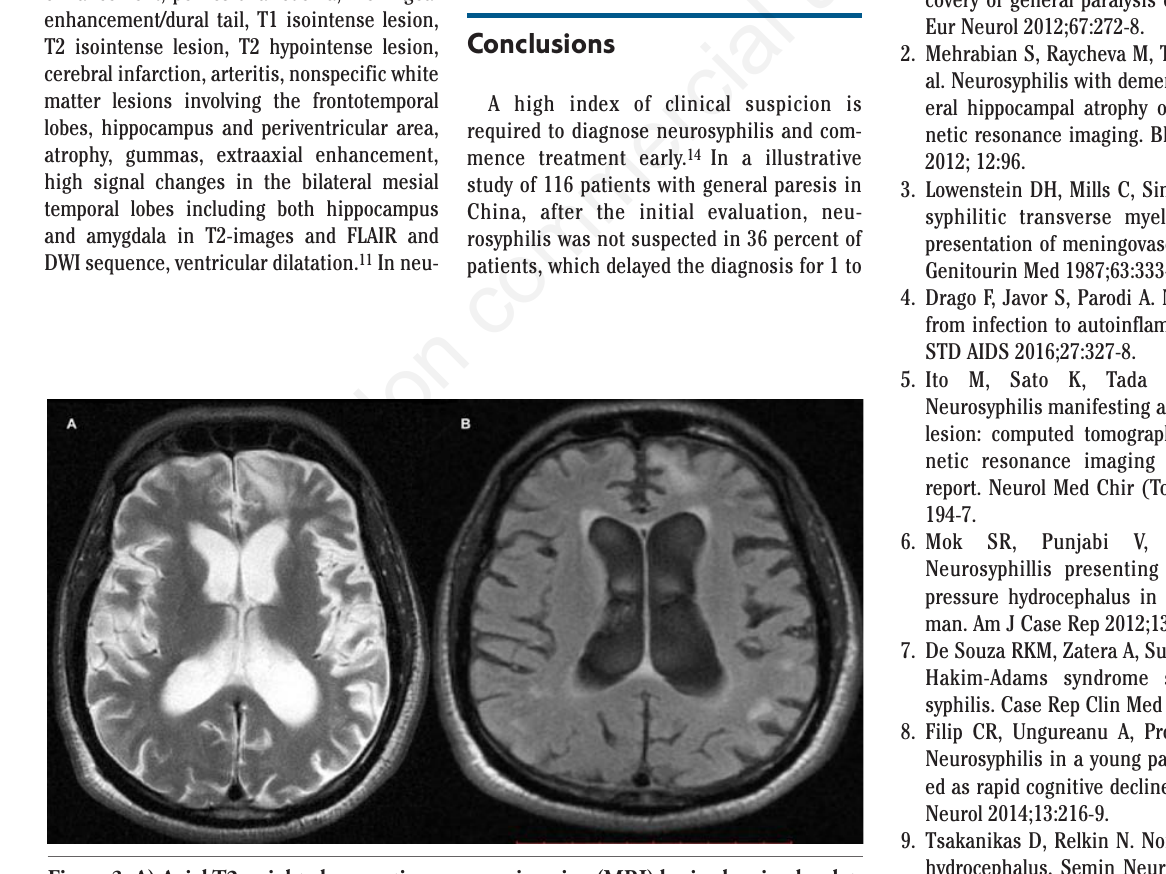
Figure 3. A) Axial T2 weighted magnetic resonance imaging (MRI) brain showing less lat- eral ventricualr dilation, compared to previous MRI; B) axial FLAIR MRI brain showing partial resolution of the left frontal subcortical hyperintensity, and much less periventric- ular